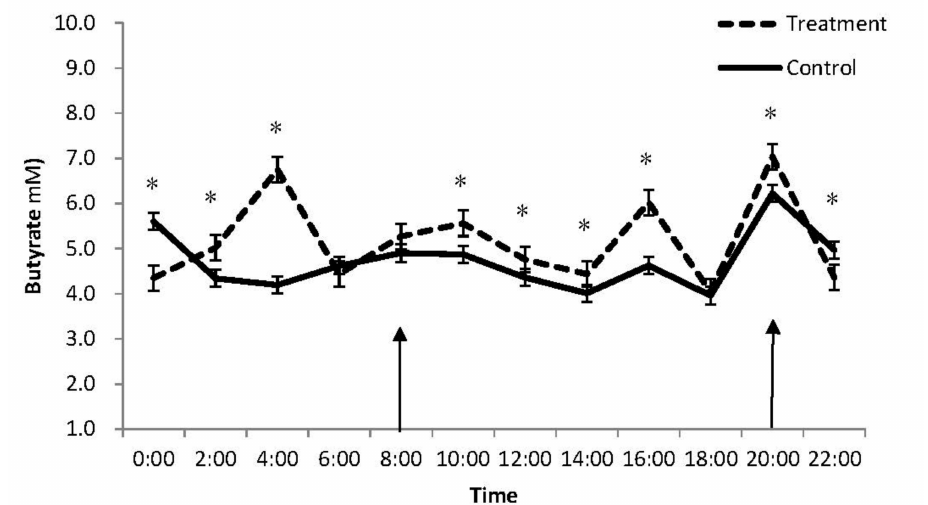
Figure 2. Diurnal e ff ects of a 4.5% licorice root extract supplementation on rumen butyrate concentration of Karakul sheep fed cottonseed hull-based diets. Arrows: feeding time; Bar: SEM; *, significant di ff erence at p <